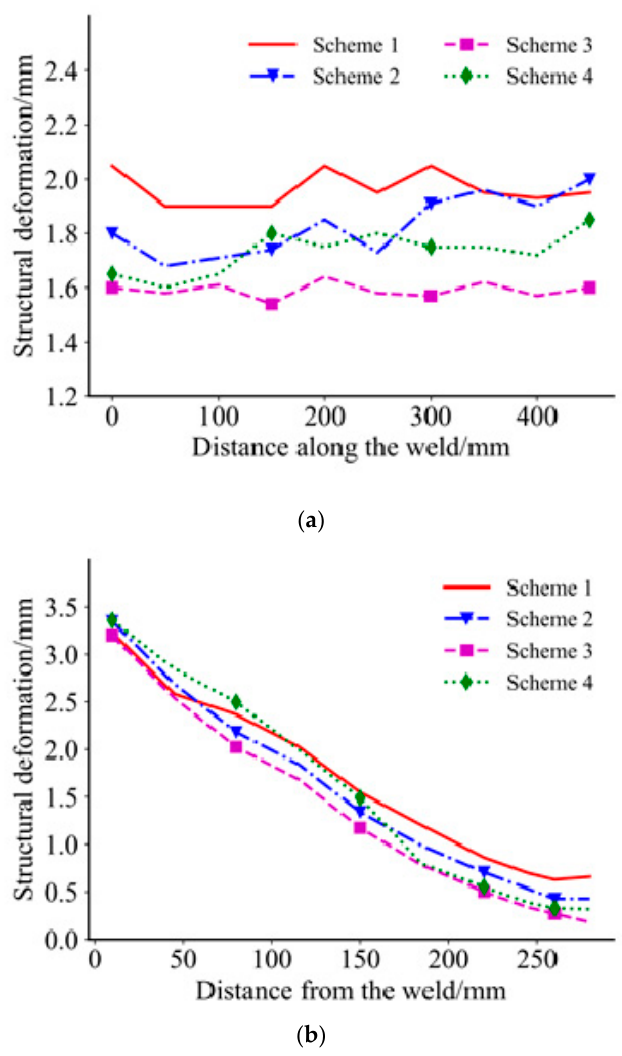
Figure 11. Comparison of deformation in parallel and perpendicular weld directions: ( a ) structural deformation in the direction of the weld; ( b ) structural deformation perpendicular to the welding